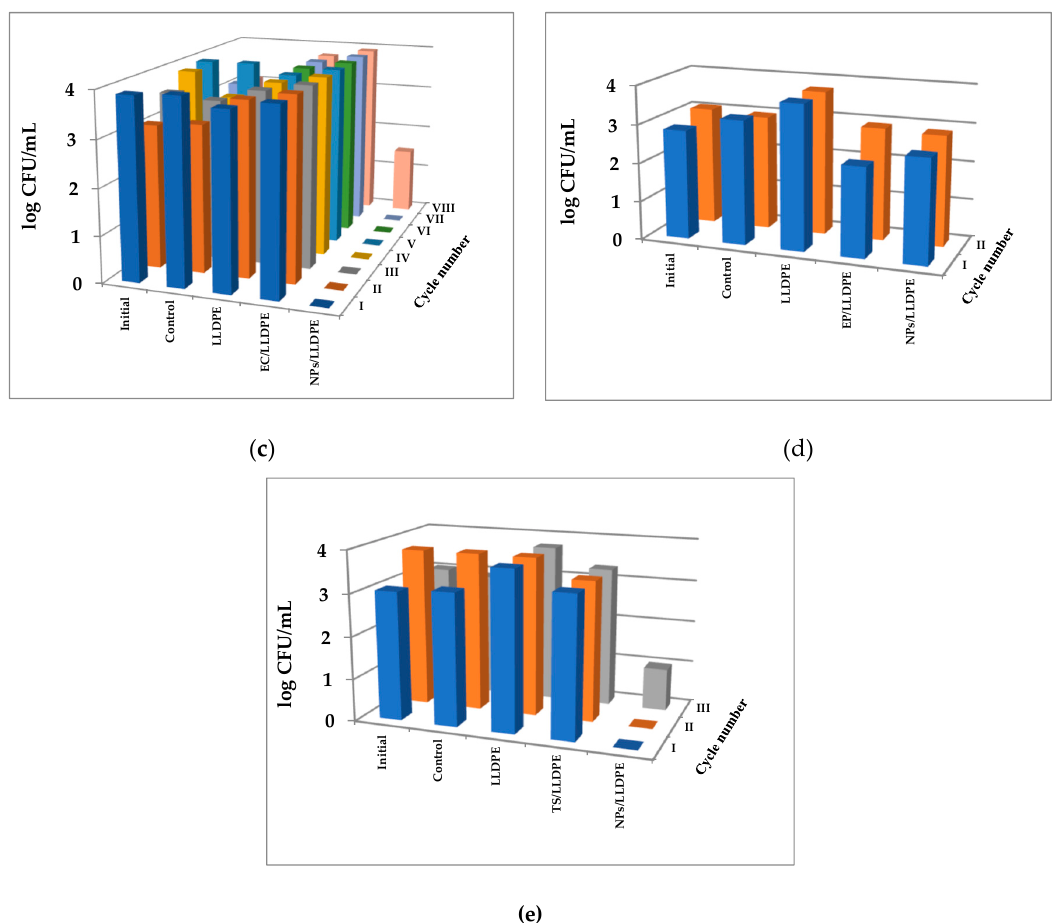
Figure 7. Activity of the Cu 2 ONPs-LLDPE composites against E. coli cells of composites obtained by: ( a ) extrusion; ( b ) thermal adhesion; ( c ) using ethyl cyanoacrylate; ( d ) using epoxy resin ( e ) using trimethoxyvinylsilane. Roman figures show the number of re-use cycles. Initial— E. coli cells before the incubation, control— E. coli cells after 30 min incubation, LLDPE— E. coli cells after 30 min incubation with LLDPE, EC/LLDPE— E. coli cells after 30 min incubation with LLDPE coated with an ethyl cyanoacrylate layer, TS/LLDPE— E. coli cells after 30 min incubation with LLDPE coated with a trimethoxyvinylsilane layer, EP/LLDPE— E. coli cells after 30 min incubation with LLDPE coated with an epoxy resin layer, NPs/LLDPE— E. coli cells after 30 min incubation with the Cu 2 ONPs-LLDPE composite. In all cases, relative standard errors did not exceed 10%.